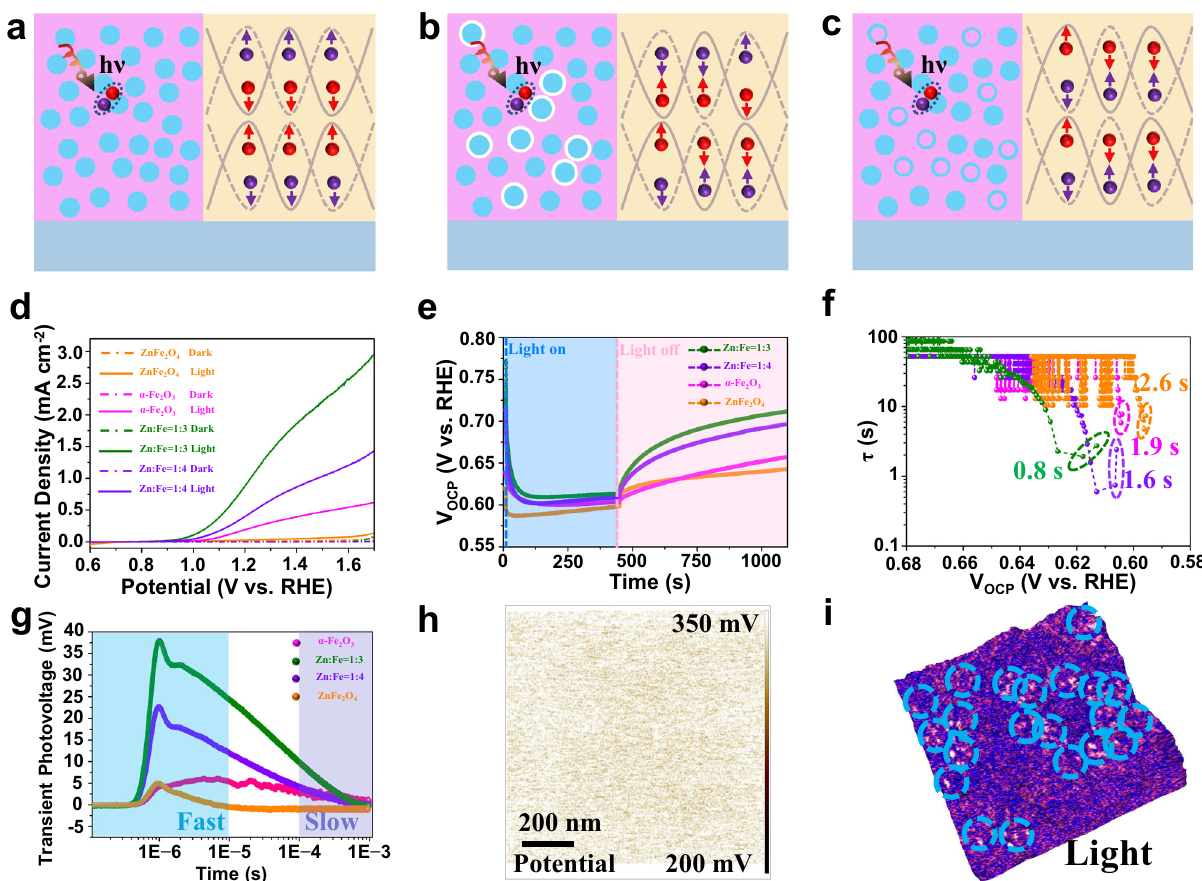
Fig. 6 Enhancement mechanism of the Turing interface fi lm. a Schematic of the fundamental processes in the Turing interface fi lm. Photon absorption and formation of the carriers and carrier separation at the interface. b Schematic of the fundamental processes in the conventional dual-phase interface fi lm. Photon absorption and formation of the carriers and carrier separation at the interface. c Schematic of the fundamental processes in the non-Turing dual-phase interface fi lm. Photon absorption and formation of the carriers and carrier separation at the interface. d Photocurrent density versus applied potential curves under 1 sun (AM 1.5 G, 100 mW cm − 2 ). e OCP curves for ZnFe 2 O 4 , the Turing interface fi lm (Zn: Fe = 1:3), the Turing interface fi lm (Zn: Fe = 1:4) and α -Fe 2 O 3 fi lms. The blue region represents the time in which the samples were under light illumination, and the pink region represents the time after the illumination was turned off. f OCP-derived carrier lifetimes. g Transient photovoltage responses (TPV). h V CPD image under 405 nm light irradiation of the Turing interface fi lm (Zn: Fe = 1:3). i Current images (3D) of the Turing interface fi lm (Zn: Fe = 1:3) overlaid under 405 nm light irradiation (1 V